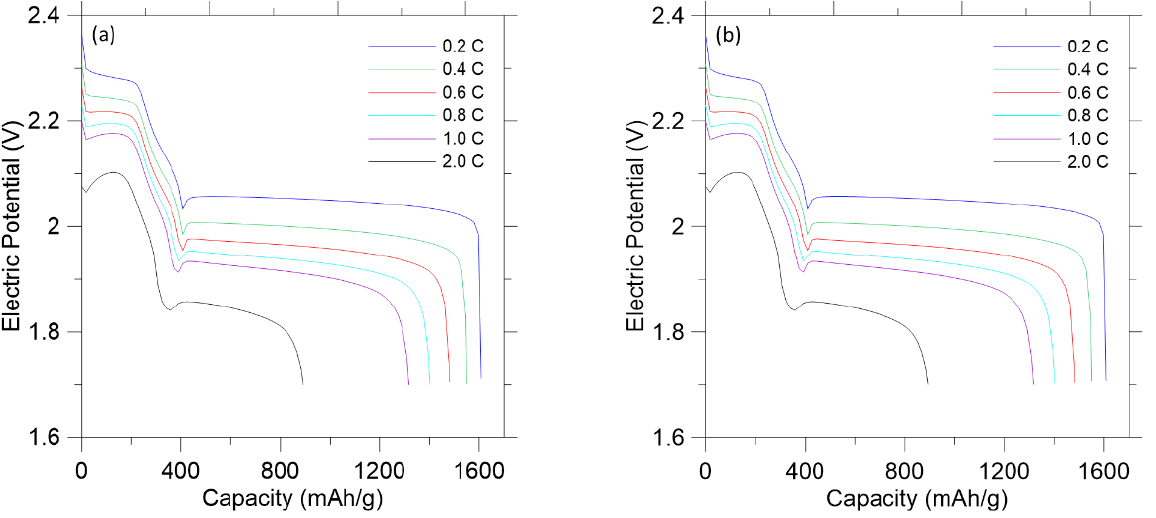
Figure 5. Discharge curves of LISBs at densities varying from 0.2 C to 2.0 C from the COMSOL model: ( a ) Without the polymer composite layer; ( b ) With the polymer composite layer.